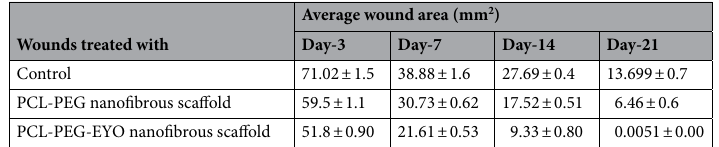
Table 1. The average wound area treated with different scaffolds at various time points.